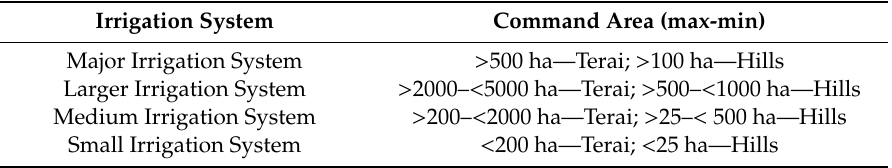
Table 2. Irrigation systems, according to the command area in